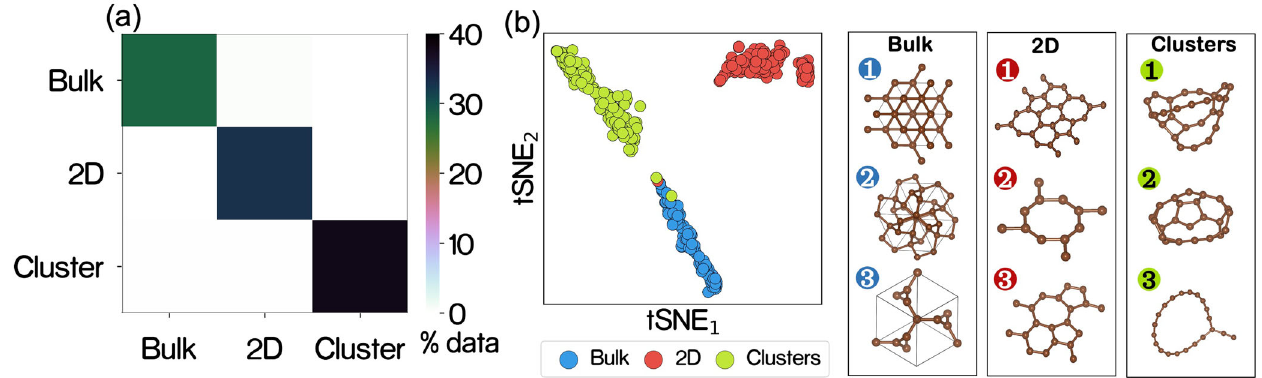
Fig. 4 Classi fi cation of carbon polymorphs of different dimensionalities 0D (Clusters), 2D (Sheets), and 3D (Bulk). a Shows the confusion matrix of the prediction on the test dataset by CEGANN. b The t-SNE plot of the feature representation of the test dataset as predicted by